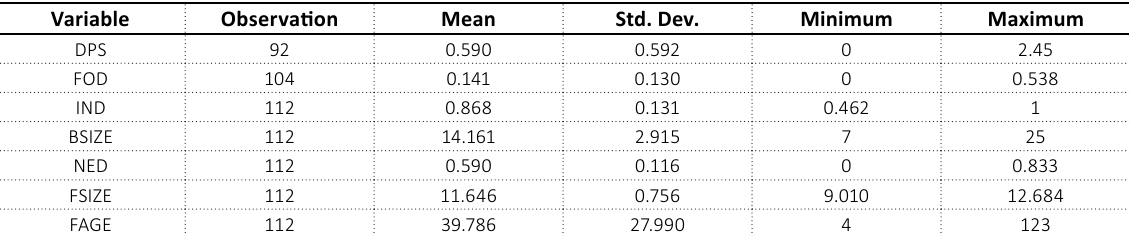
Table 2. Summary